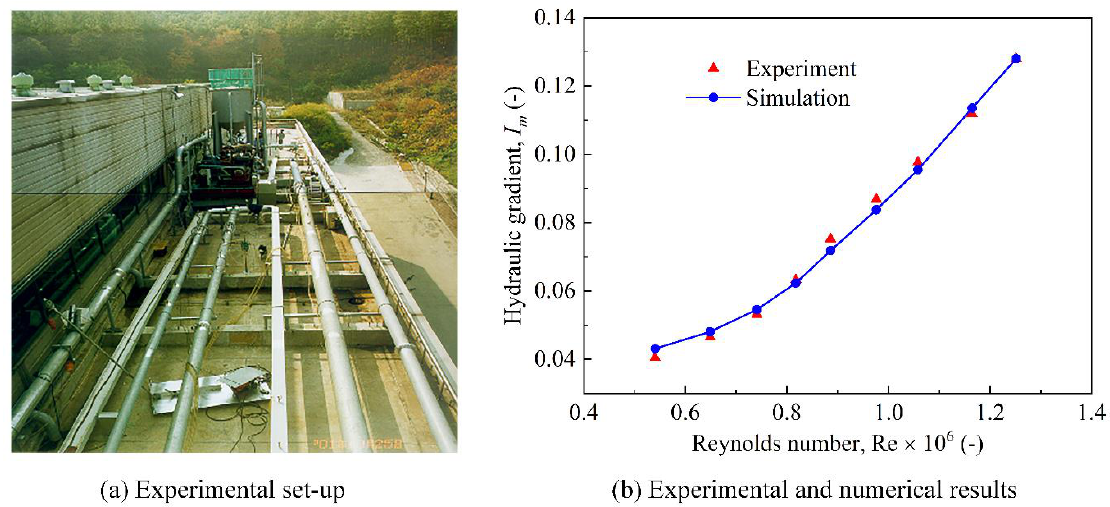
Figure 3. Effect of Reynolds number on the hydraulic gradient in sand-slurry flows ( a ) Set-up for experiments [32] and ( b ) comparison between experiments [32] and simulations.